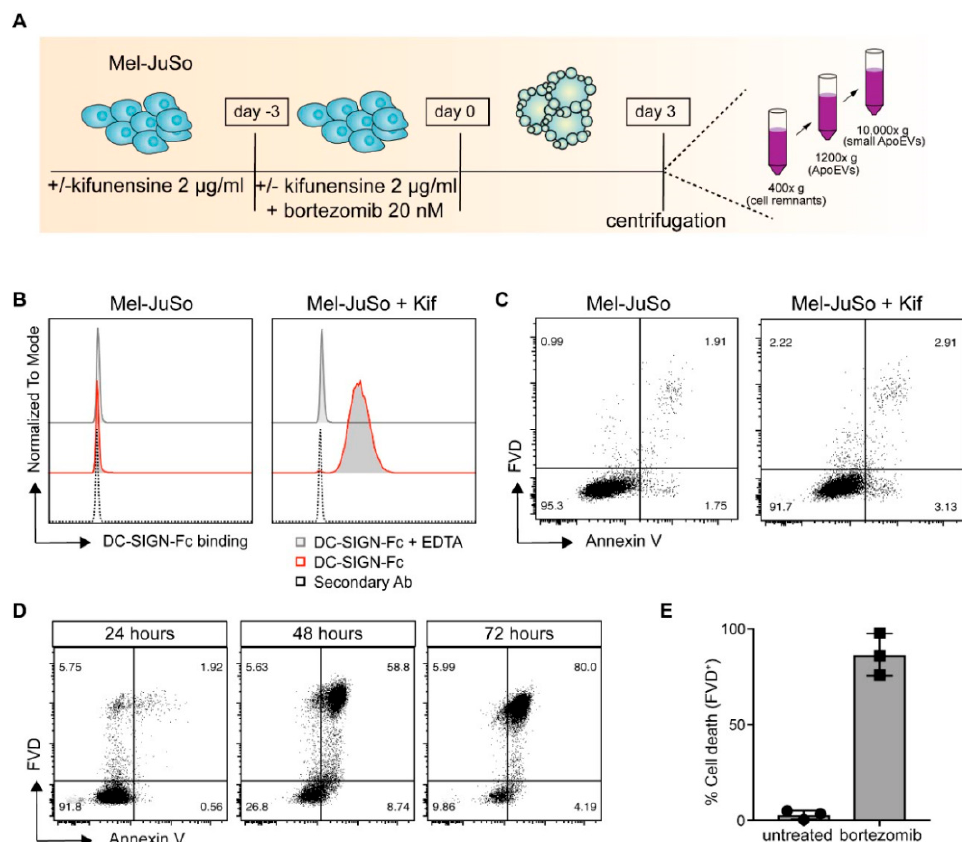
Figure 1. Characterization of kifunensine-treated Mel-JuSo cells. ( A ) Protocol of ApoEV and ApoEV-HM production and isolation procedure. ( B ) Mel-JuSo cells were cultured with kifunensine for 72 h. Dendritic cell-specific intercellular adhesion molecule-3-grabbing non-integrin (DC-SIGN) binding was